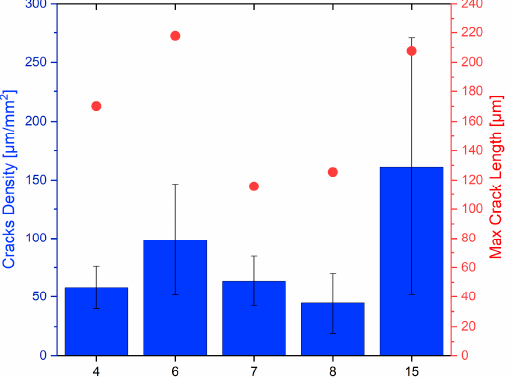
Figure 12. Mean values and standard deviations of crack density and maximum crack length measured among different prints.